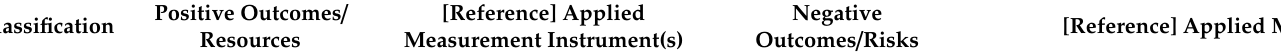
Table 2. Summary and Classification of Outcomes, Adapted Classification According to Rothe 2017